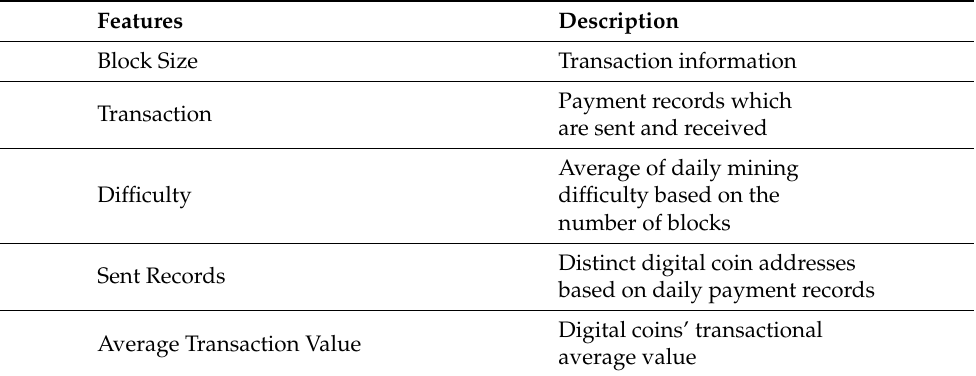
Figure 5. Different factors’ importance from 2018 to 2021. Table 4 gives the detail information related the technical indicators of the raw features. Table 4. Technical indicators’ raw